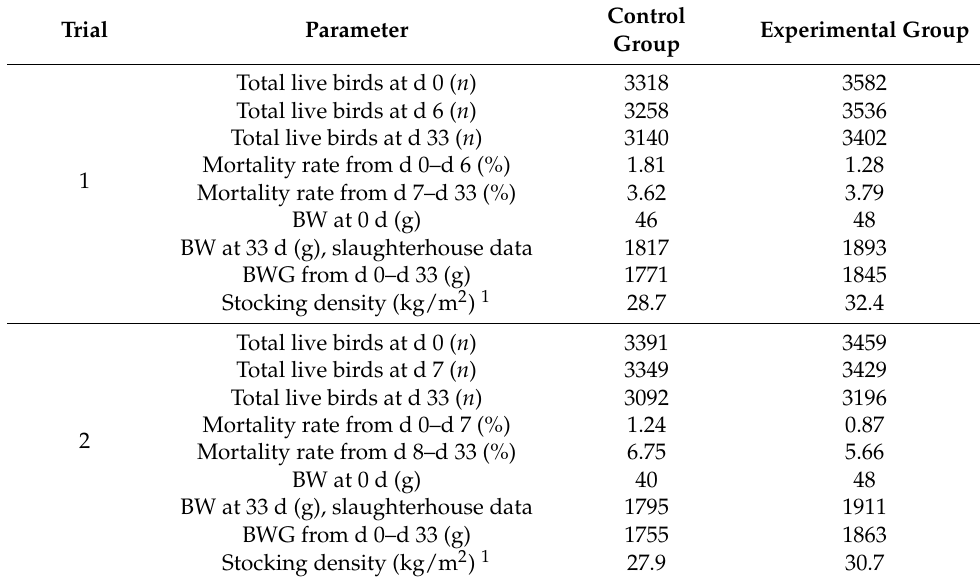
Table 6. Overall farm and slaughterhouse data for both groups for trials 1 and 2 during the entire experimental period (d 0–d